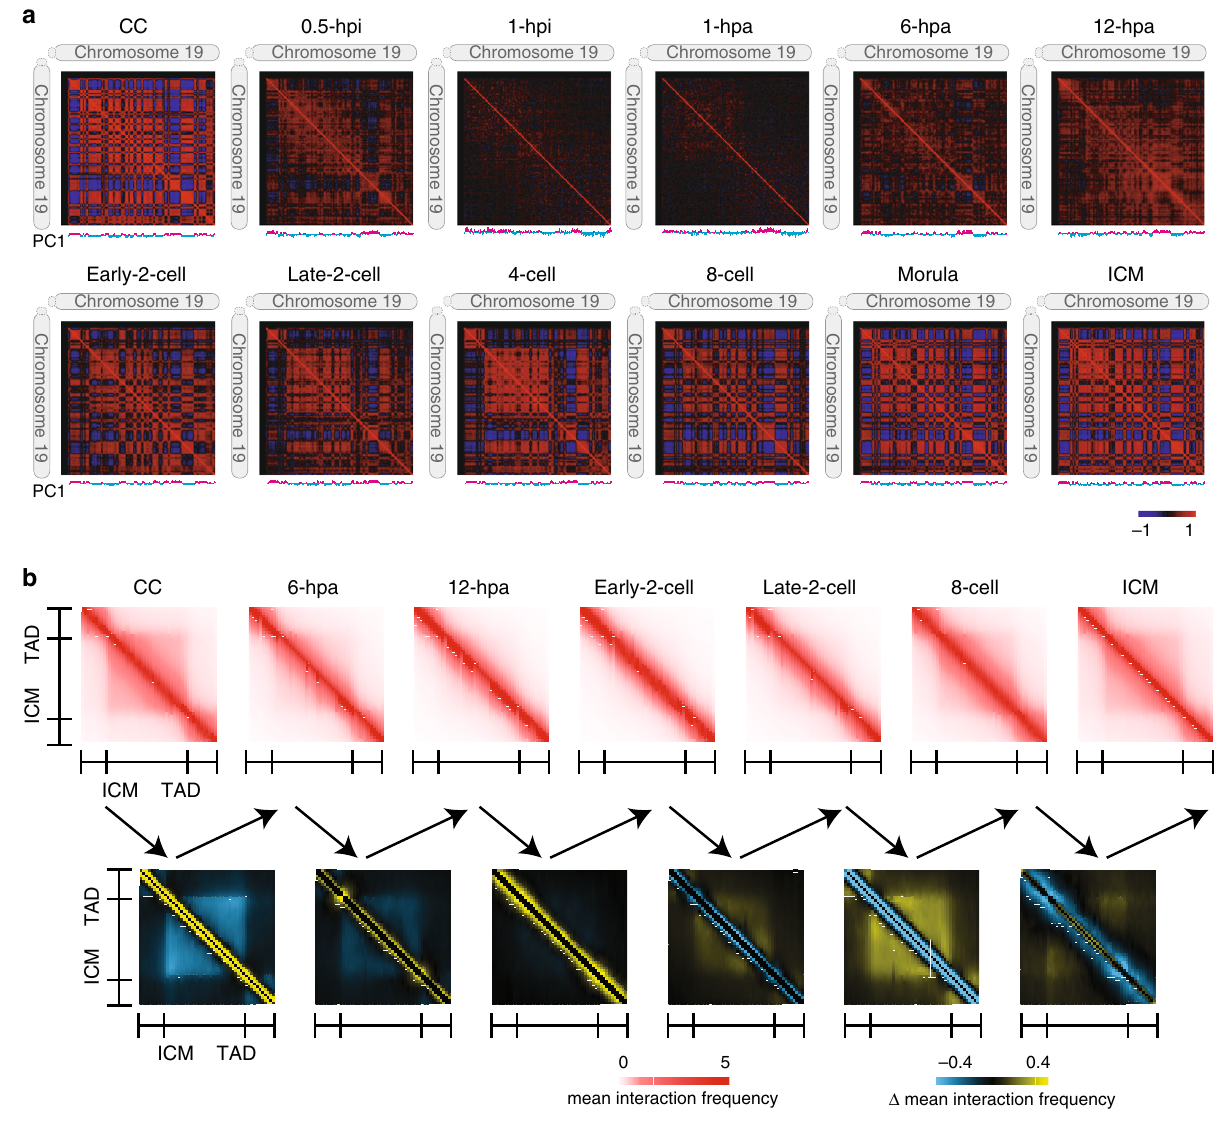
Fig. 3 Dissolution and reestablishment of 3D chromatin architecture. a Correlations of intrachromosomal interaction frequency patterns between any two regions along chromosome 19 (300-kb bin). The fi rst principle component (PC1) values are shown under each heatmap as compartments A (magenta) and B (cyan). b The top heatmaps show the mean normalized interaction frequencies for the TADs and their fl anking regions with a TAD length of ±0.5. The TADs were de fi ned in the ICM stage and used for all stages. The bottom heatmaps show the difference in the interaction frequencies between consecutive stages. Source data are provided as a Source Data fi